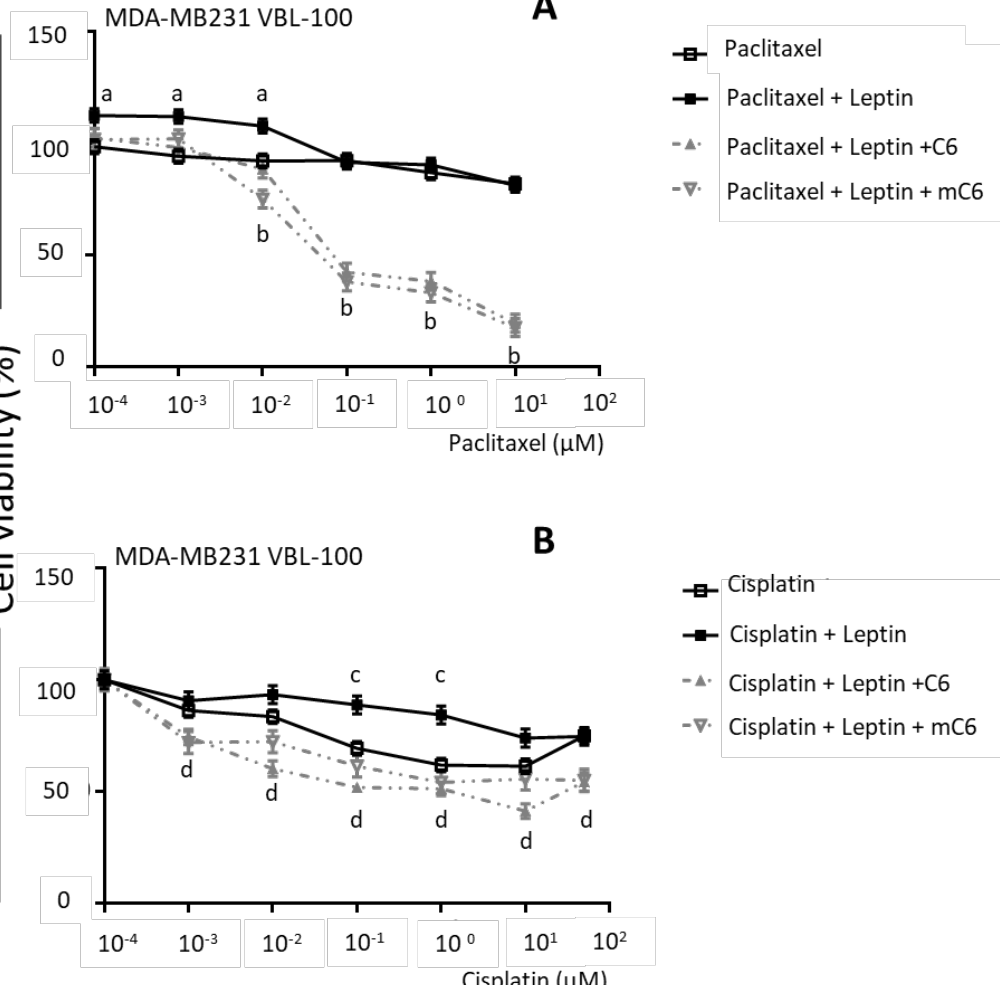
Figure 6. Leptin increases survival of chemoresistant triple-negative breast cancer cells treated with paclitaxel and cisplatin. ( A ) Paclitaxel and ( B ) cisplatin dose–response e ff ects on survival of MDA-MB231 VBL-100 breast cancer cells. Cells were treated with paclitaxel (P, 10 − 4 –10 2 µ M) or cisplatin (C, 10 − 4 –10 2 µ M); P or C + Leptin (L, 2.5 nM) and P or C + L + C6 and mC6 leptin antagonists (2.5 nM) for 72 h. CellTiter-Glo Assay was used to determine relative cell survival; “a”: p ≤ 0.05 compared to P; “b”: p ≤ 0.05 compared to P + L; “c”: p ≤ 0.05 compared to C; “d”: p ≤ 0.05 compared to C +